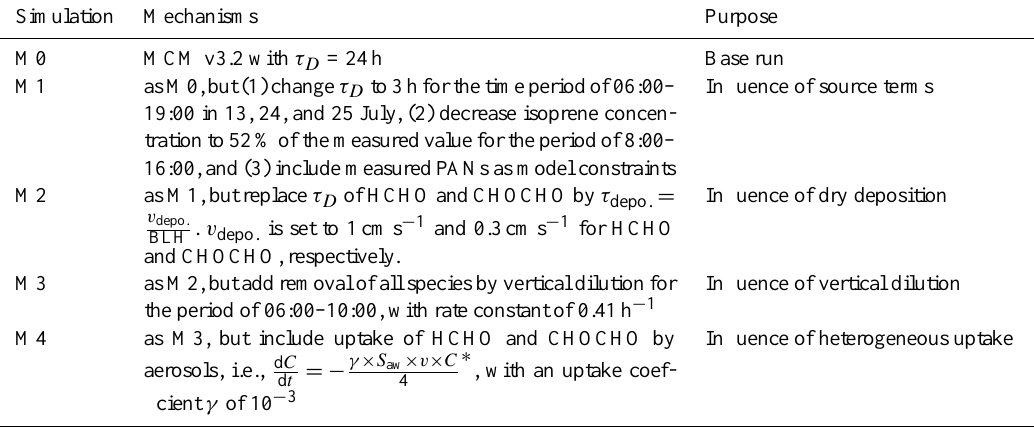
Influence of vertical